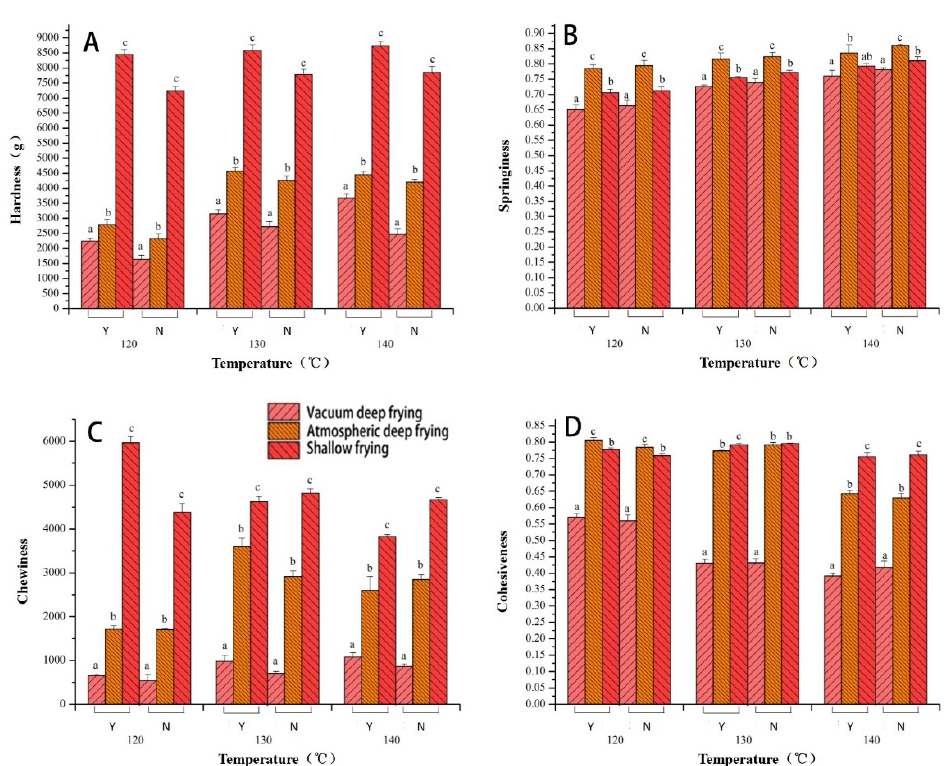
Figure 4. Effect of different processes on the texture of surimi cubes (( A ) the influence of temperature on hardness, ( B ) the influence of temperature on springiness, ( C ) the influence of temperature on chewiness, ( D ) the influence of temperature on cohesiveness. Y: Raphanus sativus added; N: no Raphanus sativus ). Different letters in the same chart represent significant differences between different treatments according to Duncan’s multiple range test. ( p < 0.05).